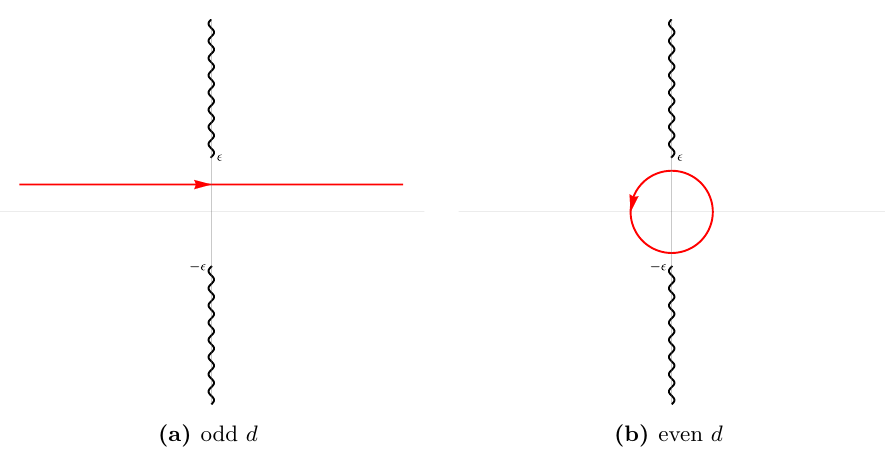
Figure 1. u -contours for even dimensional AdS (left) and odd dimensional AdS (right). The black wavy lines represent branch